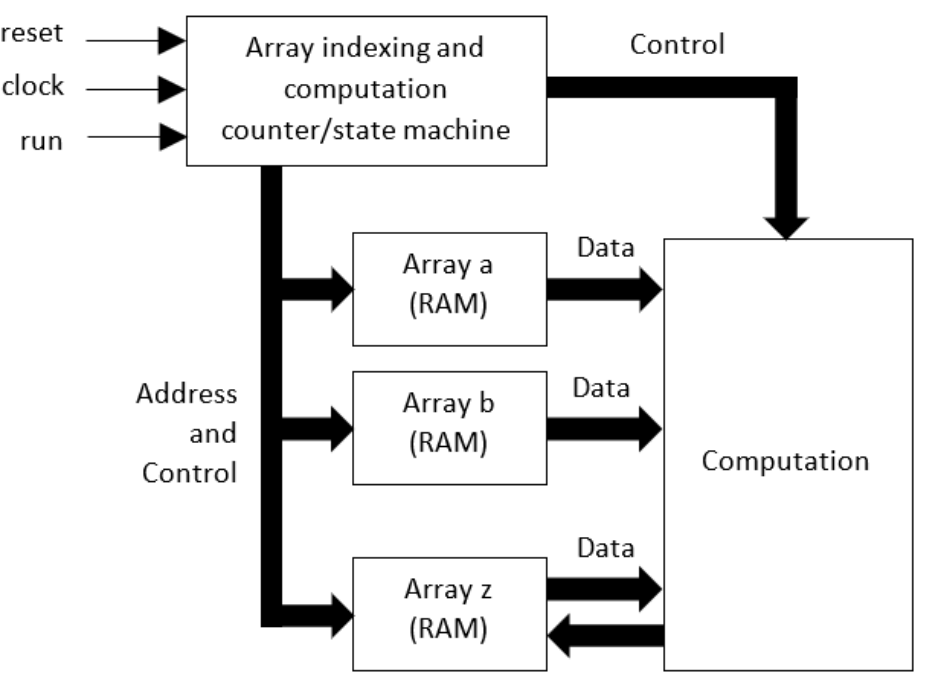
Figure 14. Simplified view of the MoA hardware design (Verilog